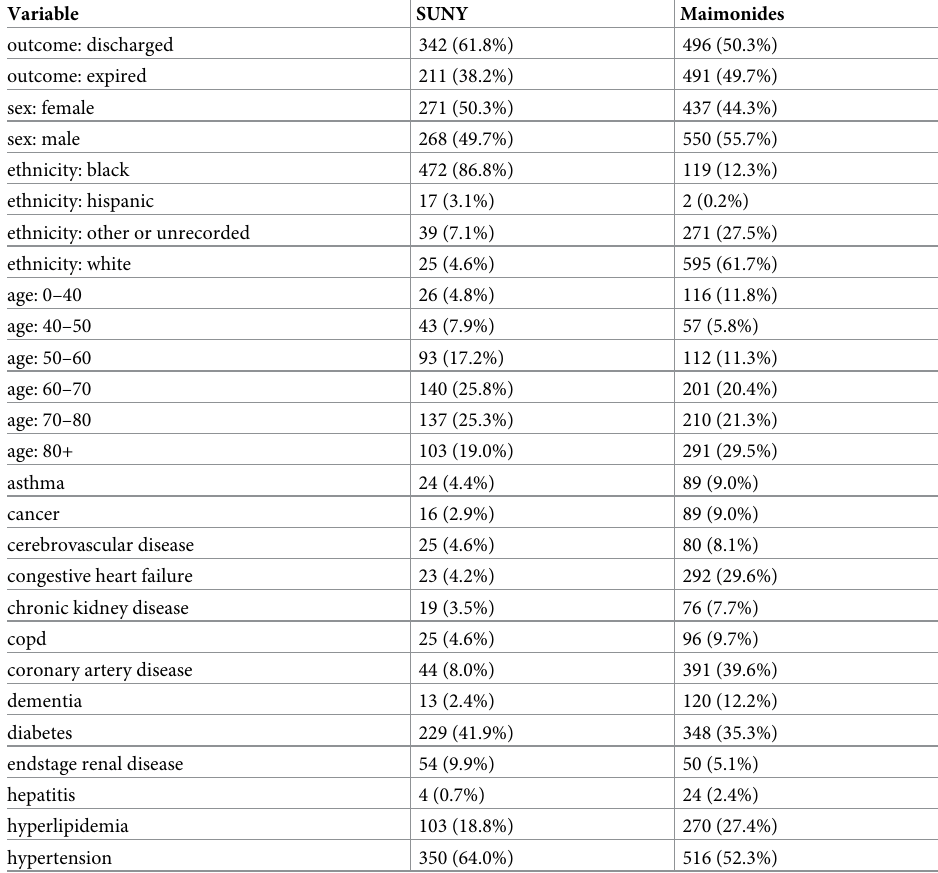
Table 1. Summary characteristics of patient groups from the two hospitals. Note, that in some cases, data were miss- ing meaning that patients counts across all shown categories do not aggregate to n = 553 for SUNY and n = 987 for